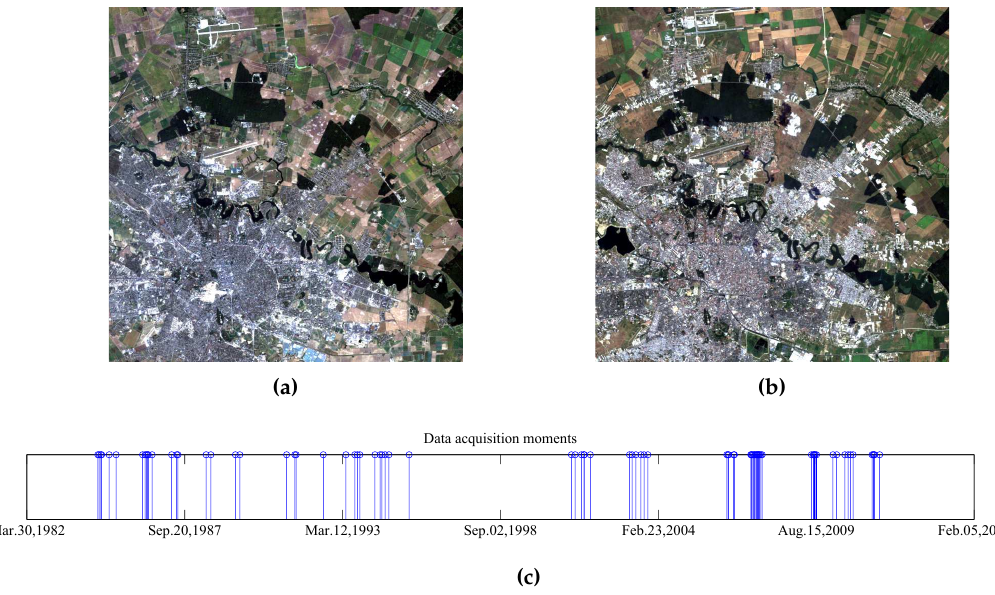
Figure 6. Long Landsat SITS comprised of 88 images captured in 1984–2011. Only the first and the last images of the series are shown, namely ( a ) 1984 and ( b ) 2011. The distribution of the acquisition moments is shown in ( c